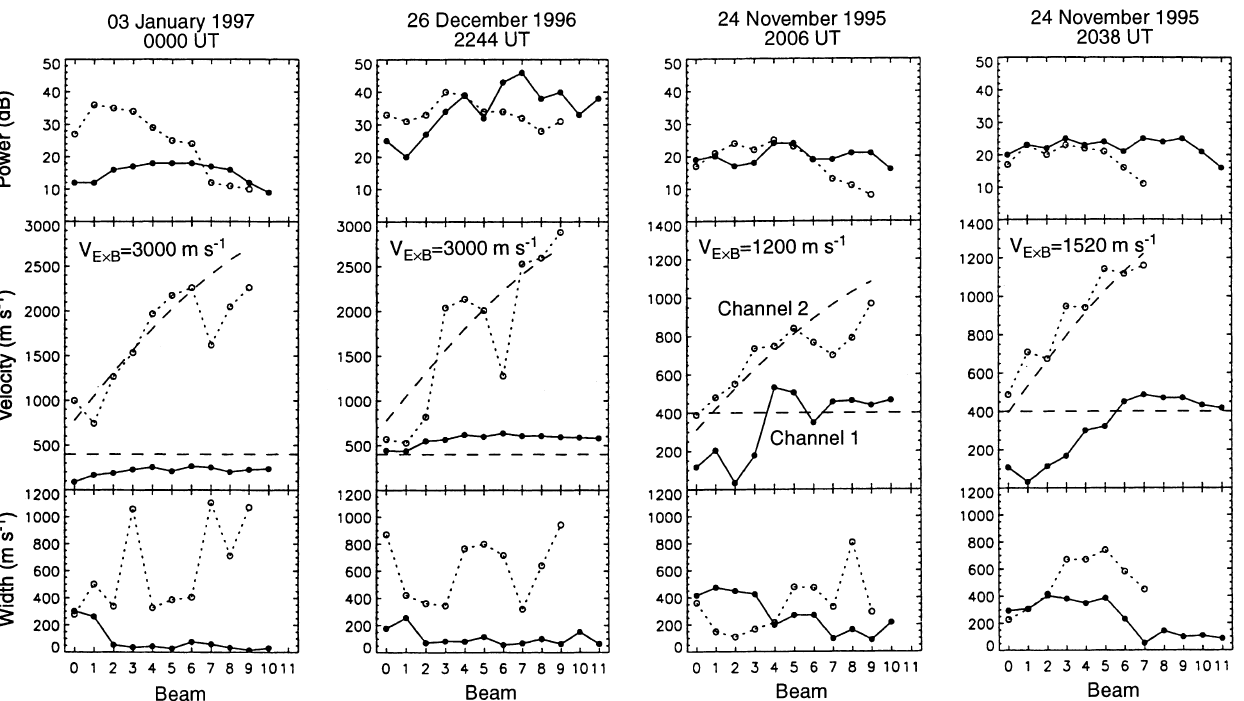
Fig. 5a–d. The backscatter power, line-of- sight velocity and spectral width observed along channel 1 ( solid lines ) and channel 2 ( dotted lines ) at a 0000 UT, 3 January 1997, b 2244 UT, 2 January 1997, c 2006 UT, 24 November 1995 and d 2038 UT, 24 November 1995. To aid comparison, a horizontal dashed line is marked at 400m s (cid:255) 1 in the velocity